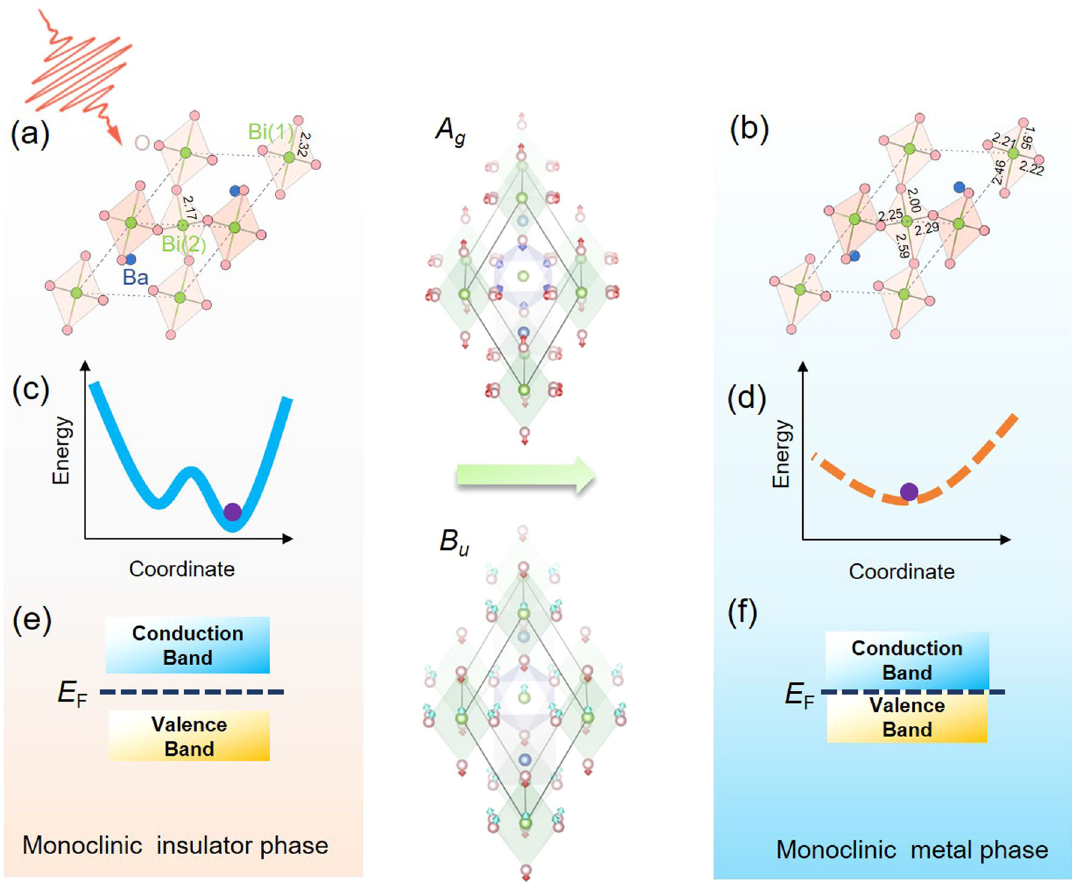
Fig. 1 Light-induced insulator-to-metal transition pathway. Schematics of a , b crystal structure, c , d energy pro fi le, and e , f band structure from insulating (left plane) to a metallic (right plane) state under the illumination of a THz pulsed laser as well as displacement patterns associated with the excited breathing ( A g ) and pumped Infrared ( B u ) phonon modes (middle